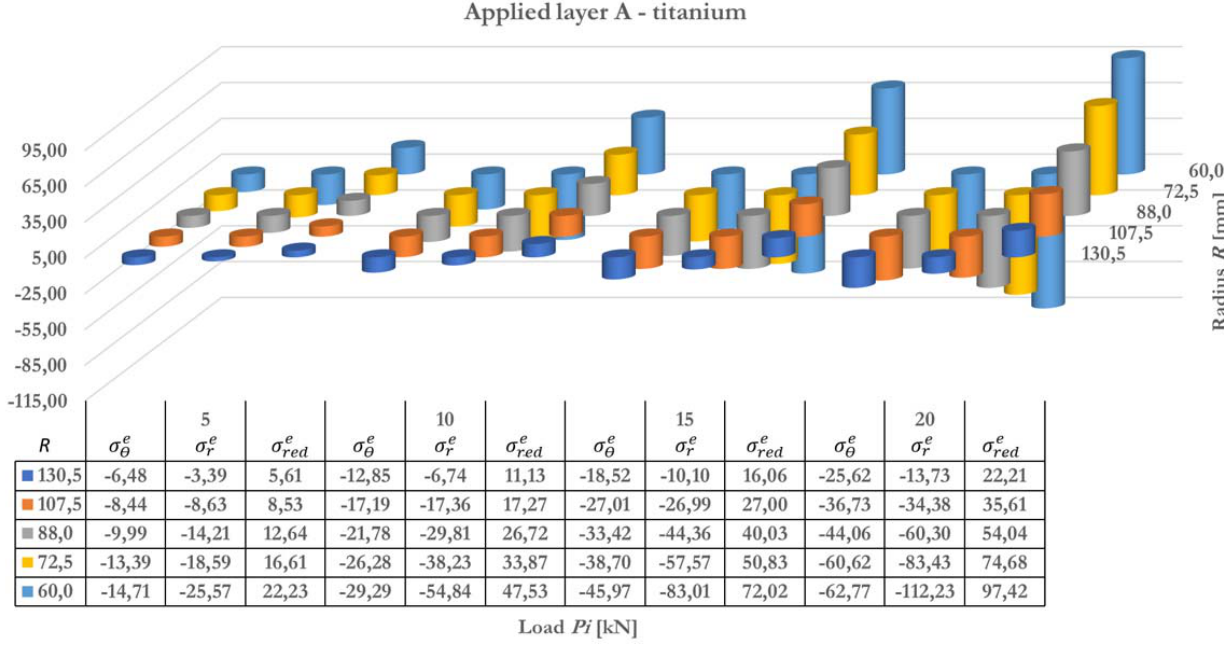
Figure 8: Summary of the stress values, respectively:   ,  r  red determined on the surface of the applied layer of the plate A – titanium, in this case, the load was applied from the side of the titanium layer.